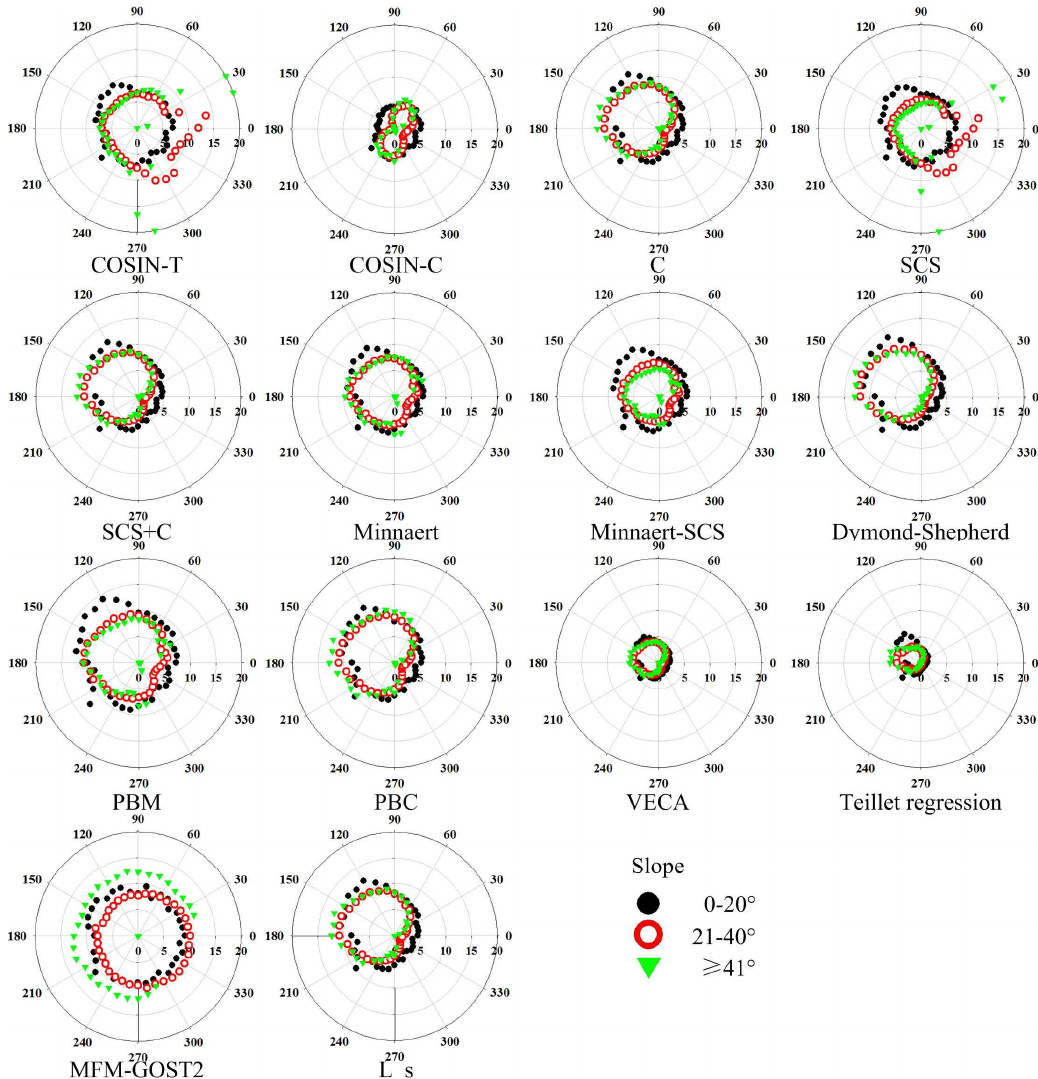
Figure 5. Changes of mean radiances in the red band with the aspect at fixed slope intervals in the study area. The polar angle represents the aspect of background (°), and the radius represents the value of radiances (W/(m 2 ·sr·μm)). L_s is the uncorrected radiance.